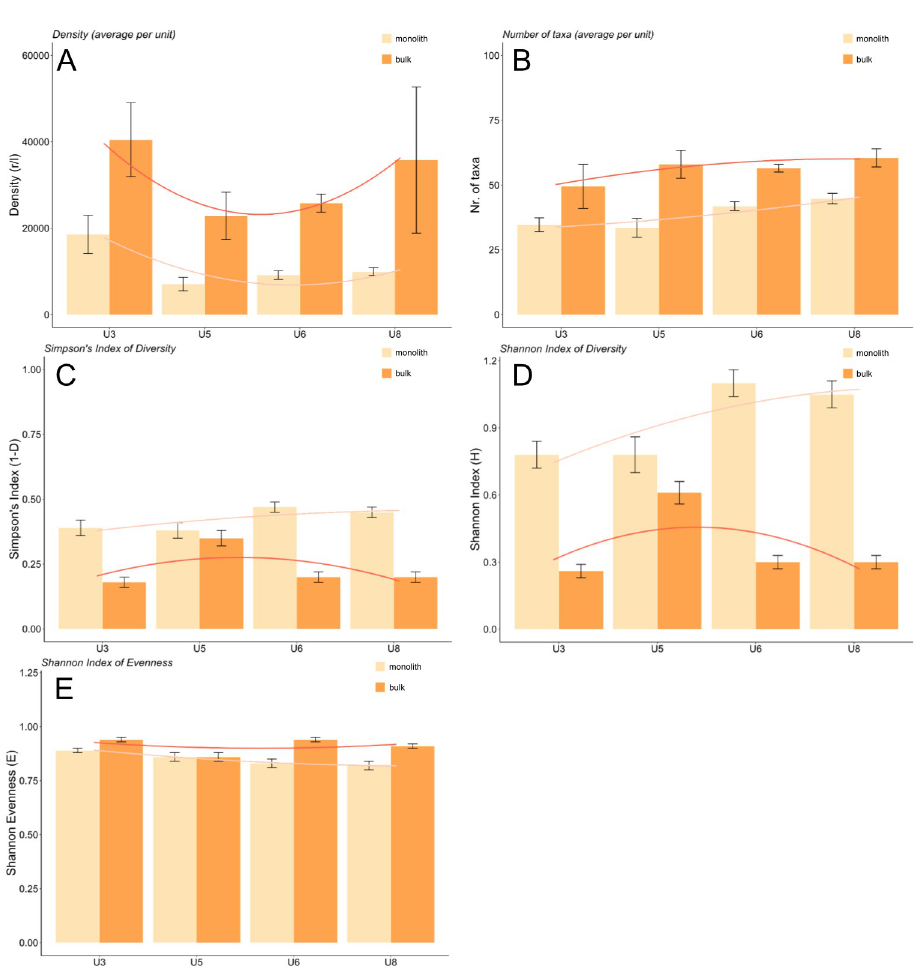
Fig 7. Plant assemblage composition (mean ± standard error) A) Density, B) number of taxa, C) Simpson’s Index of Diversity, D) Shannon Index of Diversity, E) Shannon Index of Evenness.